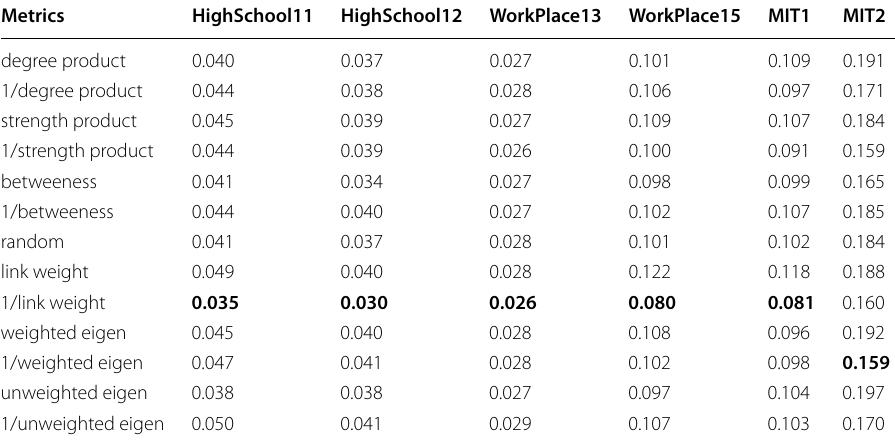
The lowest average prevalence value for each dataset is highlighted in bold